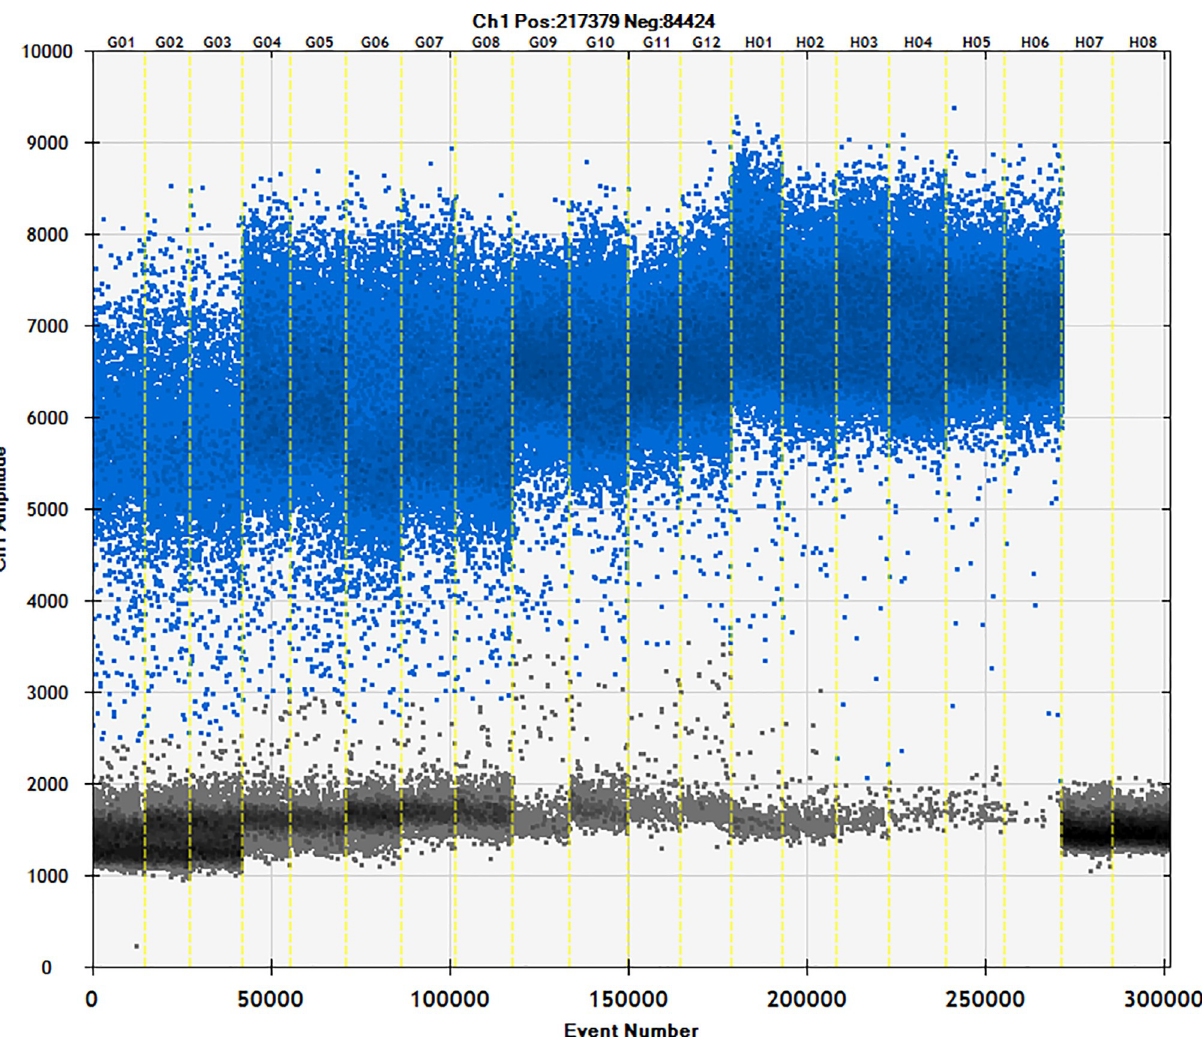
Fig 3. Correlation between the content and copy number of cassava starch DNA. DNA concentration was measured by NanoDrop 2000 and DNA copy number was determined by ddPCR.